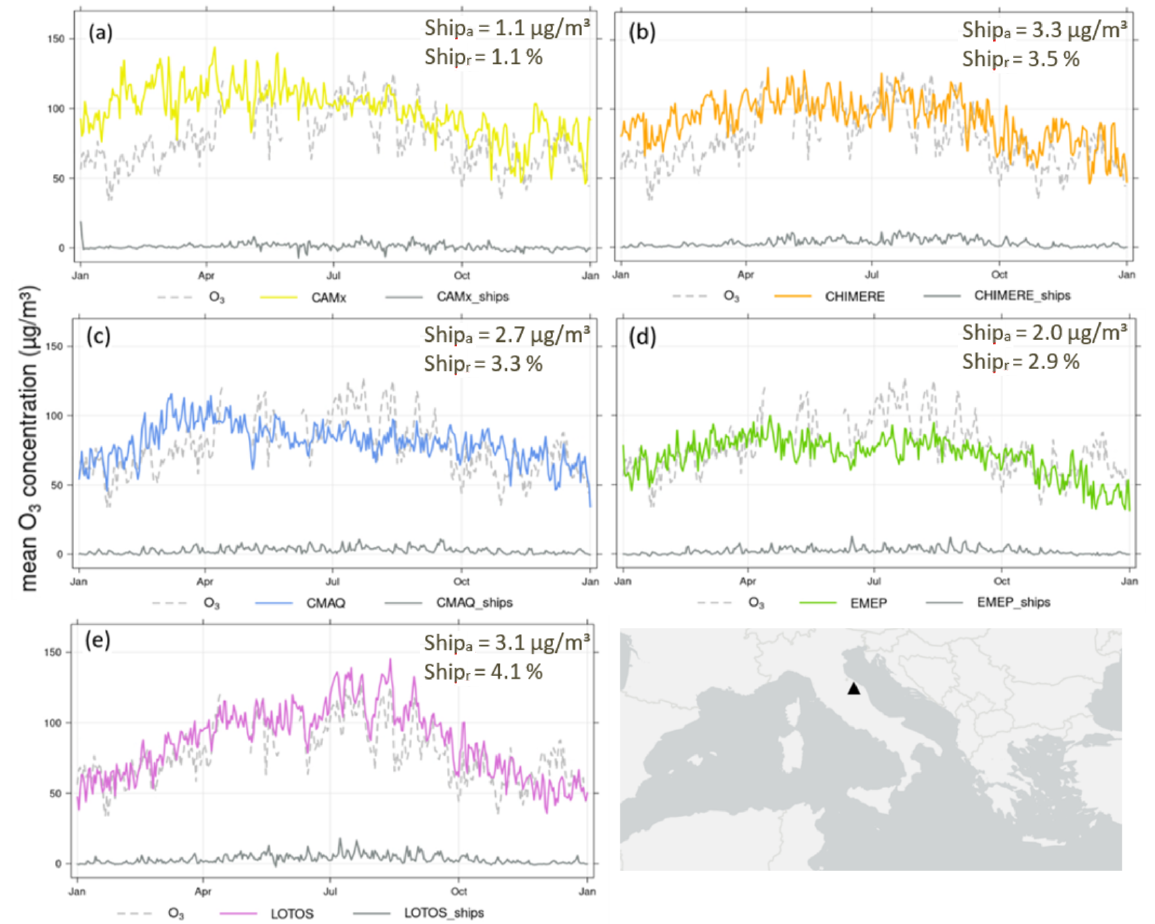
Figure D2. Time series with daily mean O 3 concentration in 2015 at station it1773a in Italy. The black triangle on the map (bottom right) displays the location of the station. (a) CAMx; (b) CHIMERE; (c) CMAQ; (d) EMEP; (e) LOTOS-EUROS. Dashed gray line – measured data; colored lines – modeled data; gray line – modeled potential ship impact. Correlation between modeled and measured data for hourly total emission data for 2015: CAMx = 0 . 37; CHIMERE = 0 . 4; CMAQ = 0 . 58; EMEP = 0 . 35; LOTOS-EUROS = 0 . 7. Ship a : potential absolute ship impact; Ship r : potential relative ship impact of the respective